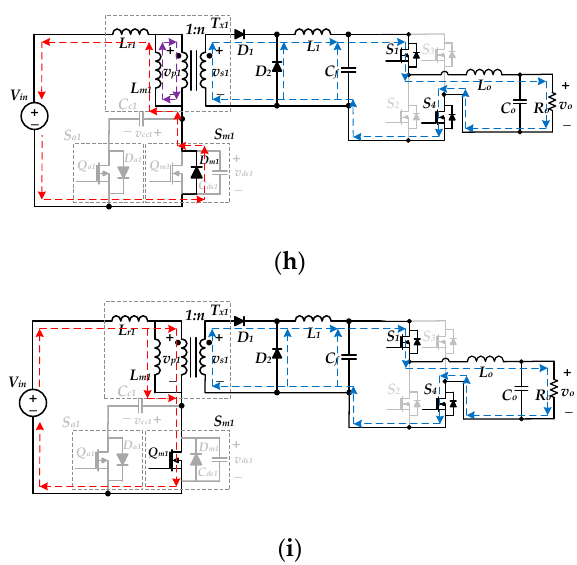
Figure 6. The equivalent circuits of each operating state during the positive half line-cycle. ( a ) State 1 [ t 0 < t < t 1 ], ( b ) state 2 [ t 1 < t < t 2 ], ( c ) state 3 [ t 2 < t < t 3 ], ( d ) state 4 [ t 3 < t < t 4 ], ( e ) state 5 [ t 4 < t < t 5 ], ( f ) state 6 [ t 5 < t < t 6 ], ( g ) state 7 [ t 6 < t < t 7 ], ( h ) state 8 [ t 7 < t < t 8 ], ( i ) state 9 [ t 8 < t < t 9 ].